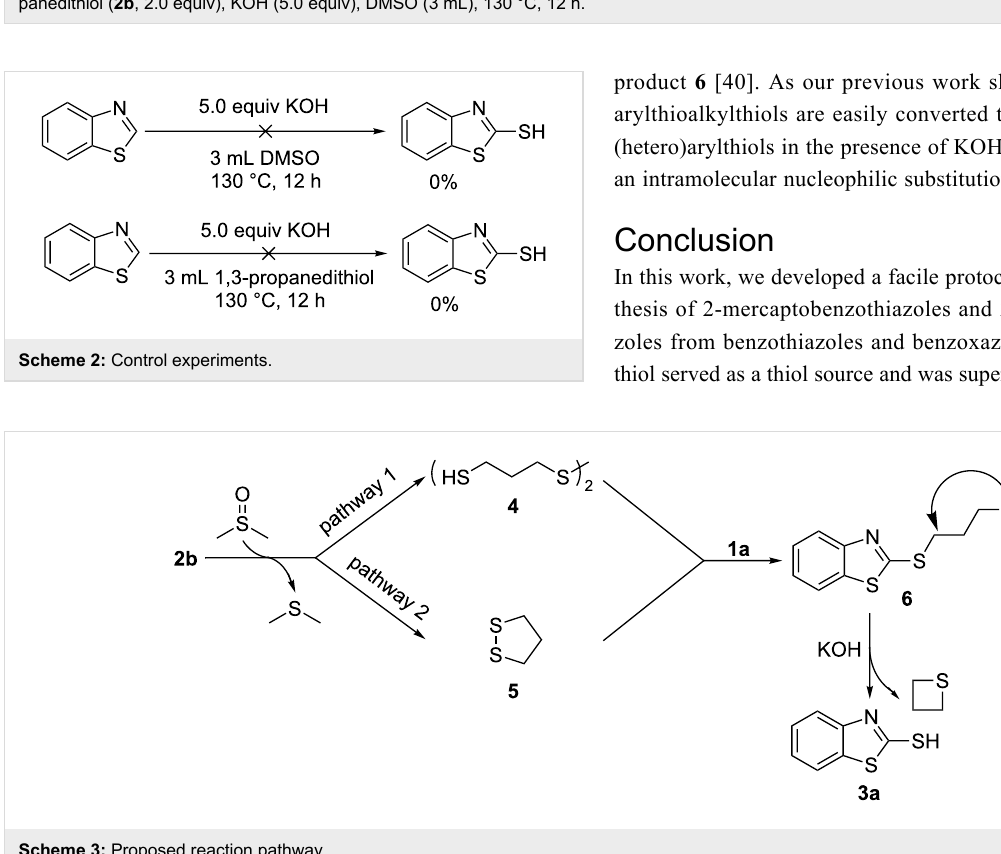
Figure 2: Substrate scope of the developed C–H mercaptalization strategy. Reaction conditions: benzothiazole or benzoxazole 1 (1.0 mmol), 1,3-pro- panedithiol ( 2b , 2.0 equiv), KOH (5.0 equiv), DMSO (3 mL), 130 °C, 12 h.